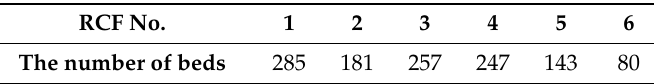
Table 3. The numbers of beds in newly-added